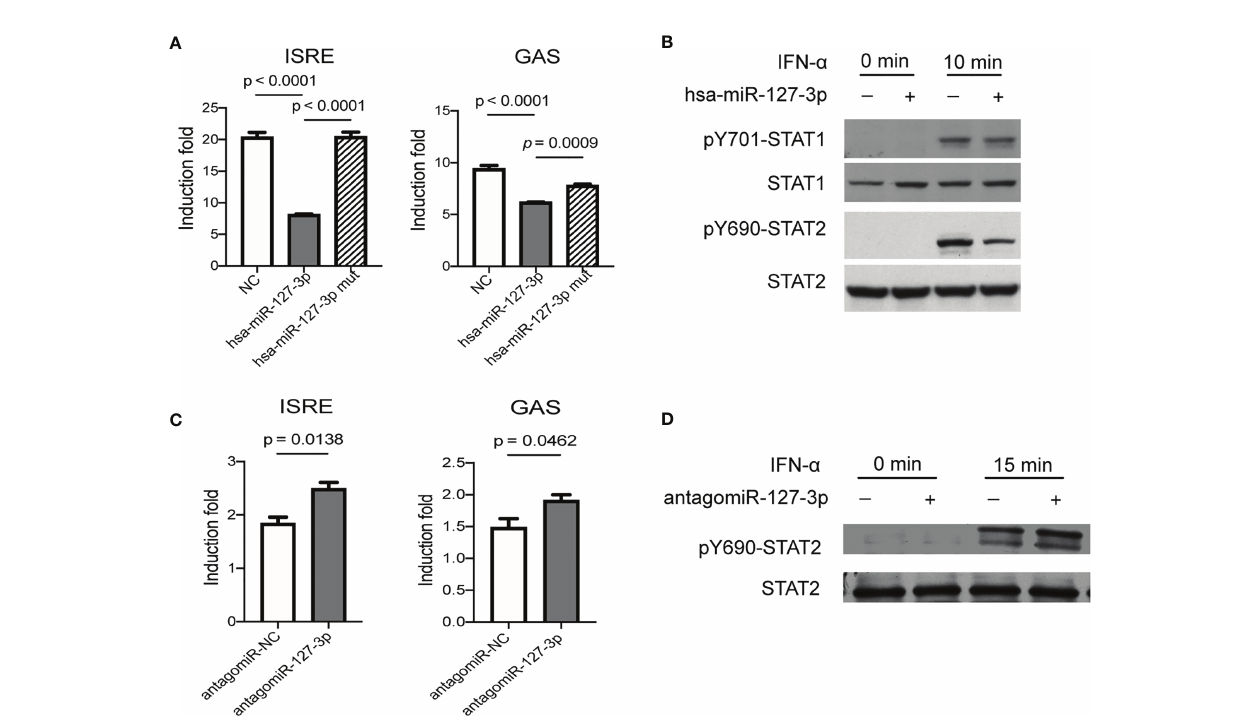
FIGURE 1 | Hsa-miR-127-3p negatively regulates IFN-I signaling pathway. (A) Hela cells transfected with ISRE-luciferase reporter (left) or GAS-luciferase reporter (right) and pRL-TK vectors together with negative control mimics (NC), hsa-miR-127-3p mimics, or hsa-miR-127-3p mutants (mut) were stimulated with universal type I interferon for 8 h. Fire fl y (F) and renilla (R) luciferase activities were measured. (B) Hela cells transfected with negative control mimics (-) or hsa-miR-127-3p mimics (+) were stimulated with universal type I interferon for 0- or 10-min. Western blot for STAT-1 and STAT-2, and phosphorylated STAT-1(pY701) and STAT-2 (pY690). (C) Primary HRMCs transfected with ISRE-luciferase reporter (left) or GAS-luciferase reporter (right) and pRL-TK vectors together with negative control antagomiR (antagomiR-NC), or hsa-miR-127-3p antagomiR (antagomiR-127-3p) were stimulated with universal type I interferon for 8 h. F and R luciferase activities were measured. (D) Primary HRMCs transfected with negative control antagomiR (-), or hsa-miR-127-3p antagomiR (+) were stimulated with universal type I interferon for 0- or 15-min. Western blot for STAT-2 and STAT-2(pY690). (A, C) The induction fold was calculated by dividing the F/R ratio of a sample in experimental groups by the F/R ratio of an unstimulated control sample. (B, D) Representative pictures from at least 3 independent experiments. (A, C) Data from at least 3 independent experiments are plotted and presented as mean±SEM. P values were determined by Mann-Whitney